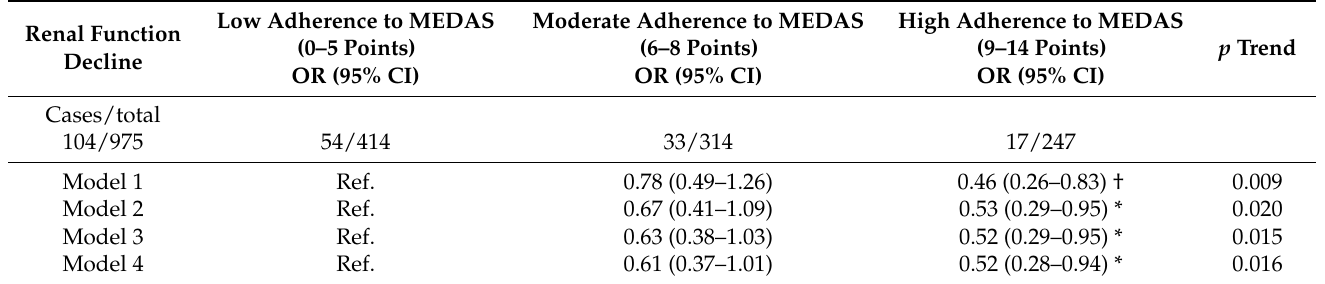
Table 2. Association between the adherence to the Mediterranean Diet Adherence Screener (MEDAS) index and the risk of renal function decline after 6.5-years of follow-up in the Seniors-ENRICA study (2008/2010–2015) N =